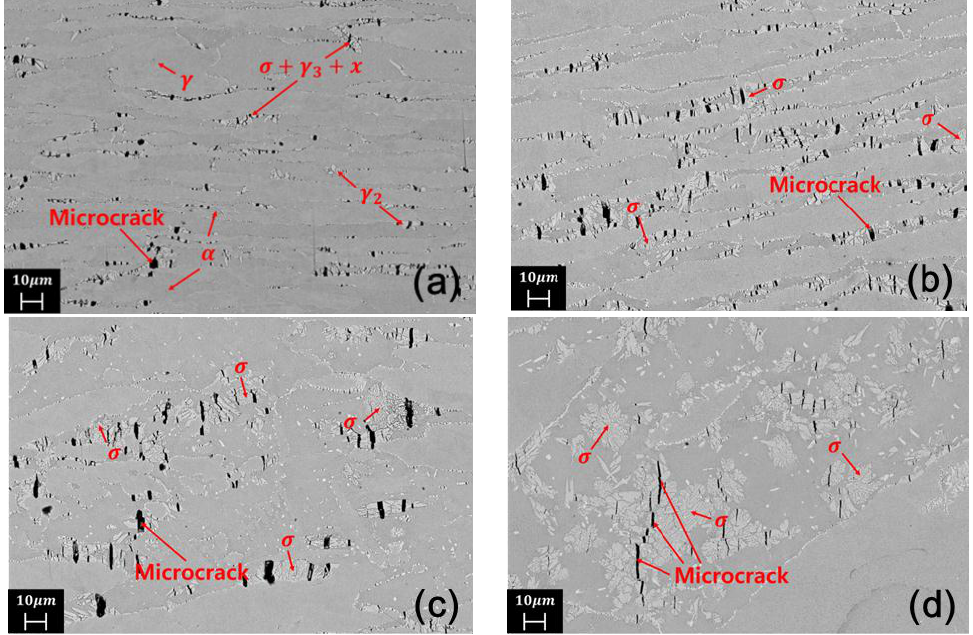
Figure 7. Precipitation of SDSS according various isothermal ageing period ( a ) 5 min; ( b ) 10 min; ( c ) 15 min; and ( d ) 30